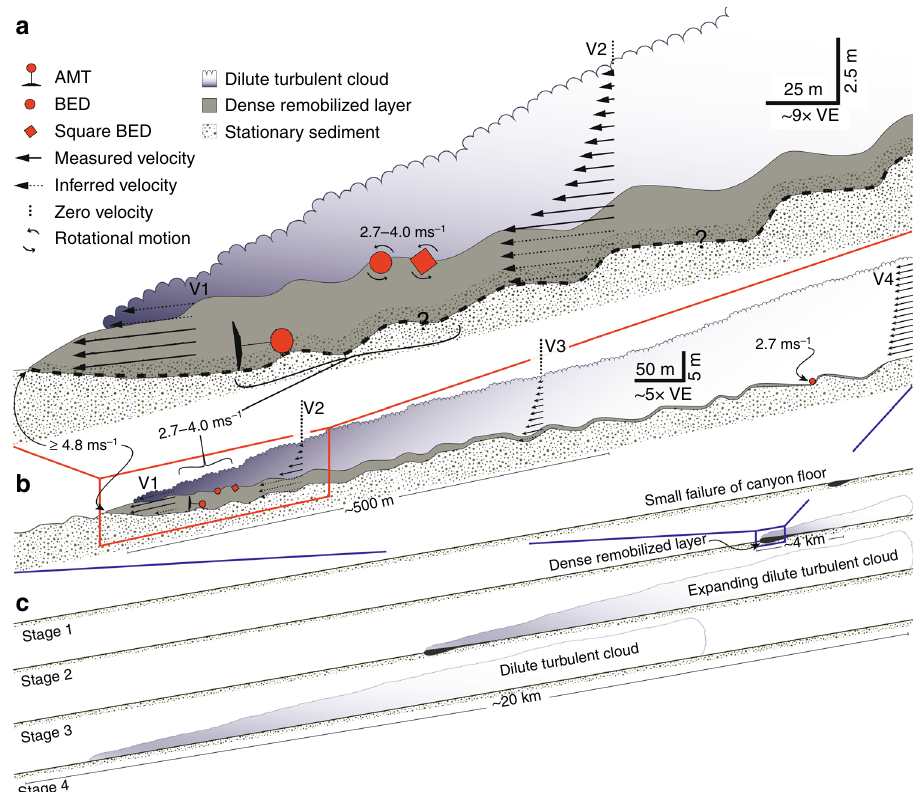
Fig. 6 Conceptual drawings of sediment density fl ow events in Monterey Canyon. a The highest velocities (V 1 ) occur in a dense basal layer near the fl ow front. This dense basal layer forms via liquefaction or mechanical erosion of underlying loose-packed sand, and helps to generate trains of crescentic bedforms. b Increased turbidity in the water column is coincident with slowing of the remobilized layer. c The evolution of a fl ow as it progresses down canyon. (Stage 1) A failure in the canyon fl oor results in the liquefaction of the sea fl oor at the front of the fl ow, (Stage 2) it propagates down-canyon as a dense remobilized layer, (Stage 3) the fast fl ow progressively generates an expanding dilute turbulent cloud, (Stage 4) which continues as a dilute turbidity current